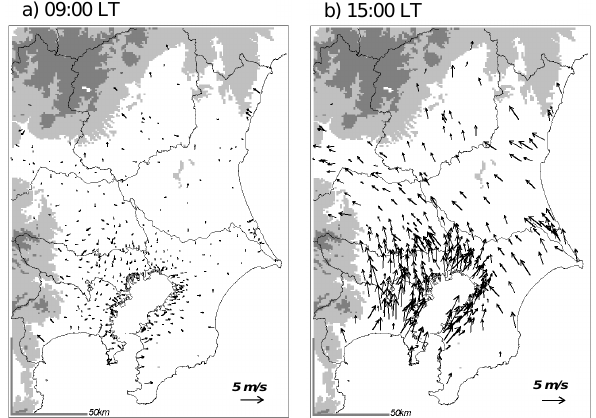
Fig. 5. Mean observed surface wind vectors at (a) 09:00LT and (b) 15:00LT on weekdays at the 95–100th percentile rank of the TMA ozone level during 1999–2004. Light (dark) gray areas indi- cate mountainous areas higher than 300m (1000m). Features on Sundays are similar to those on